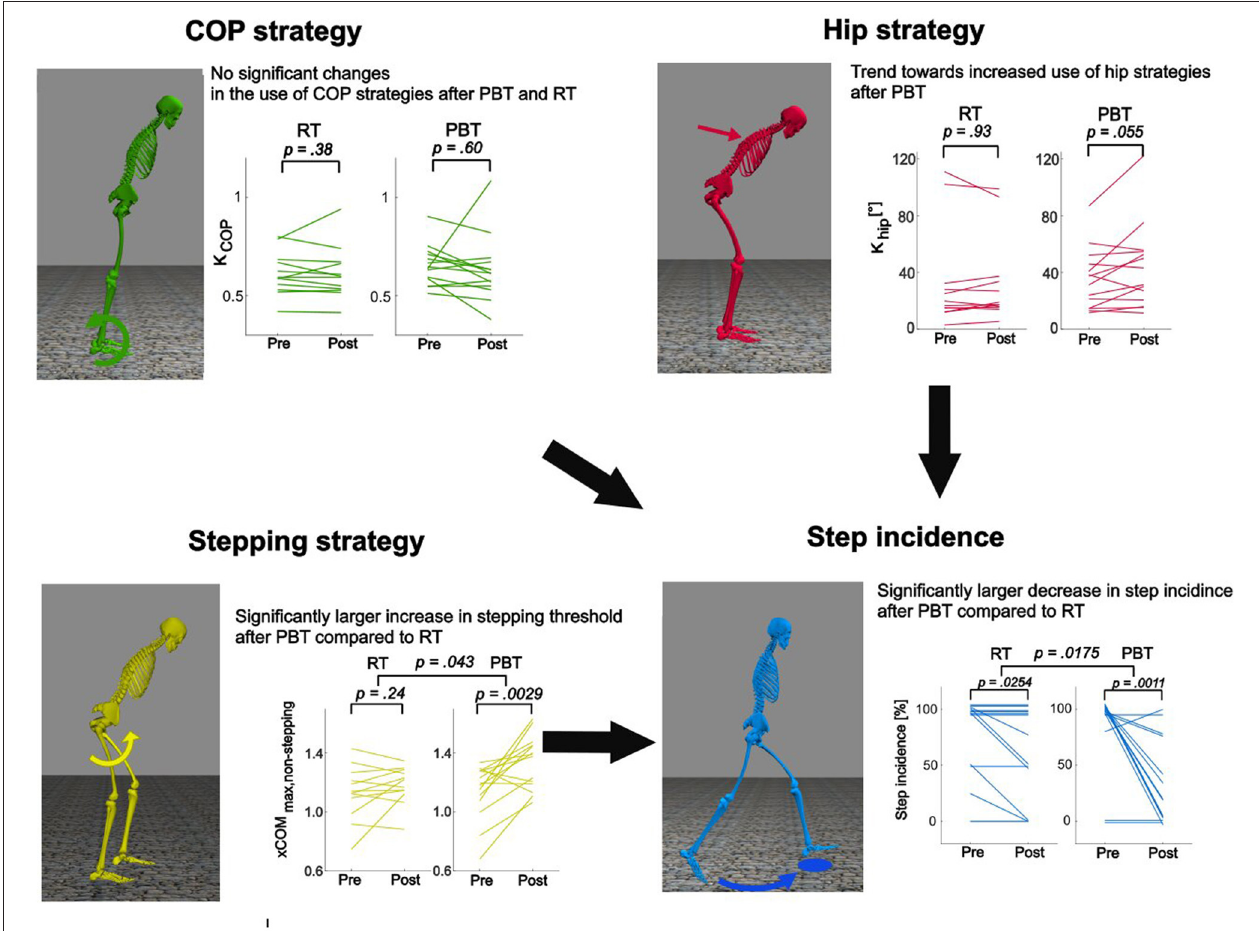
FIGURE 3 | Effects of resistance training (RT) and perturbation-based training (PBT) on reactive standing balance performance and strategies. Step incidence during backward perturbations of standing decreased more after PBT than after RT. Improvements in step incidence were not explained by changes in the COP strategy defined by the sensorimotor transformation from xCOM to T A . A trend toward increased use of hip strategies might have contributed to the decreased step incidence. Increased reliance on hip strategies was observed in some but not all individuals. Most likely, decreased step incidence might be due to changes in reliance on step strategies quantified by a significant change in stepping threshold after PBT that was not observed after